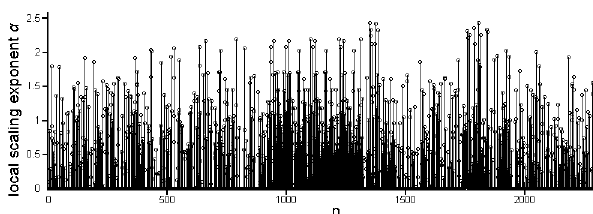
Fig. 4. The local scaling exponent α versus point n of the series. Points with missing data in the abscissa represent that the series are not singular at these